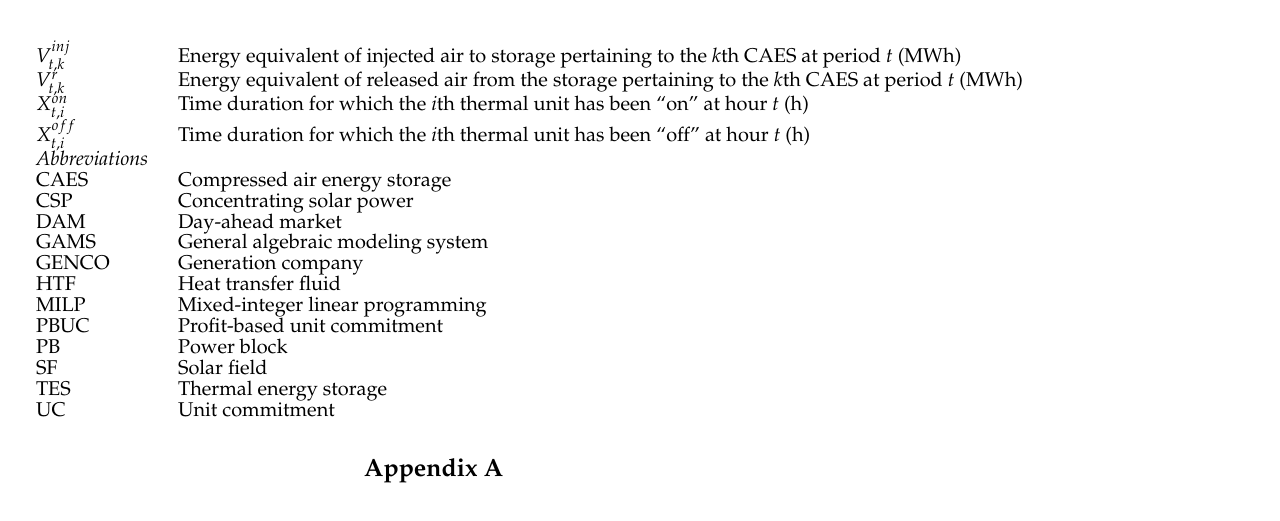
Table A1. Optimal operation scheduling for the conventional thermal units in case 1.